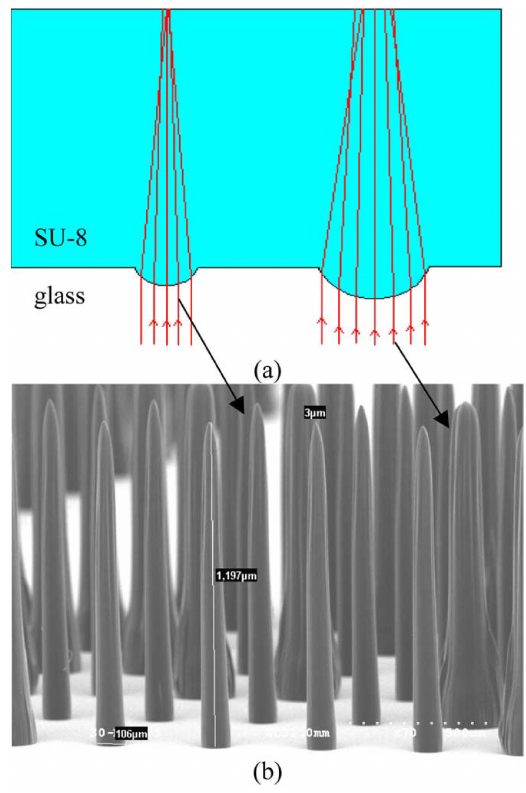
Figure 8. A conceptual schematic diagram ( a ) and an SEM image ( b ) of back-side UV exposure with integrated convex lens for creating tall and sharp conical microneedle array with thickness of 1197 μ m and tip diameter of 3 μ m. Reprinted with permission from [33], copyright 2006